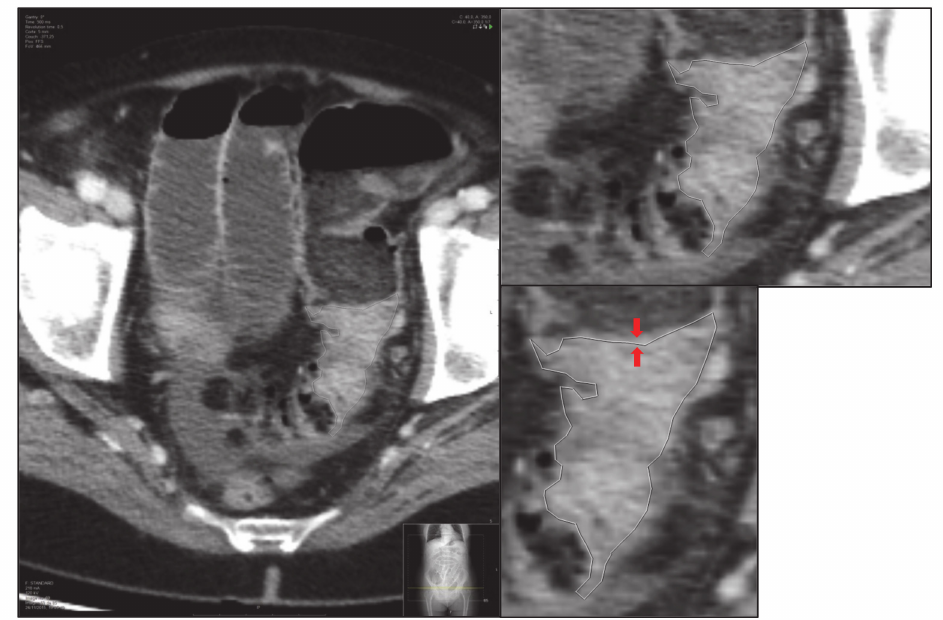
Figure 3. “Small-delimited”. To take this image, starting from the “large-delimited” image, the zoom is enlarged focusing on the delimited tumour. In the two adjacent small images, the delimited tumour can be seen in detail. In the enlarged image the delimitation is highlighted between the two red arrows.